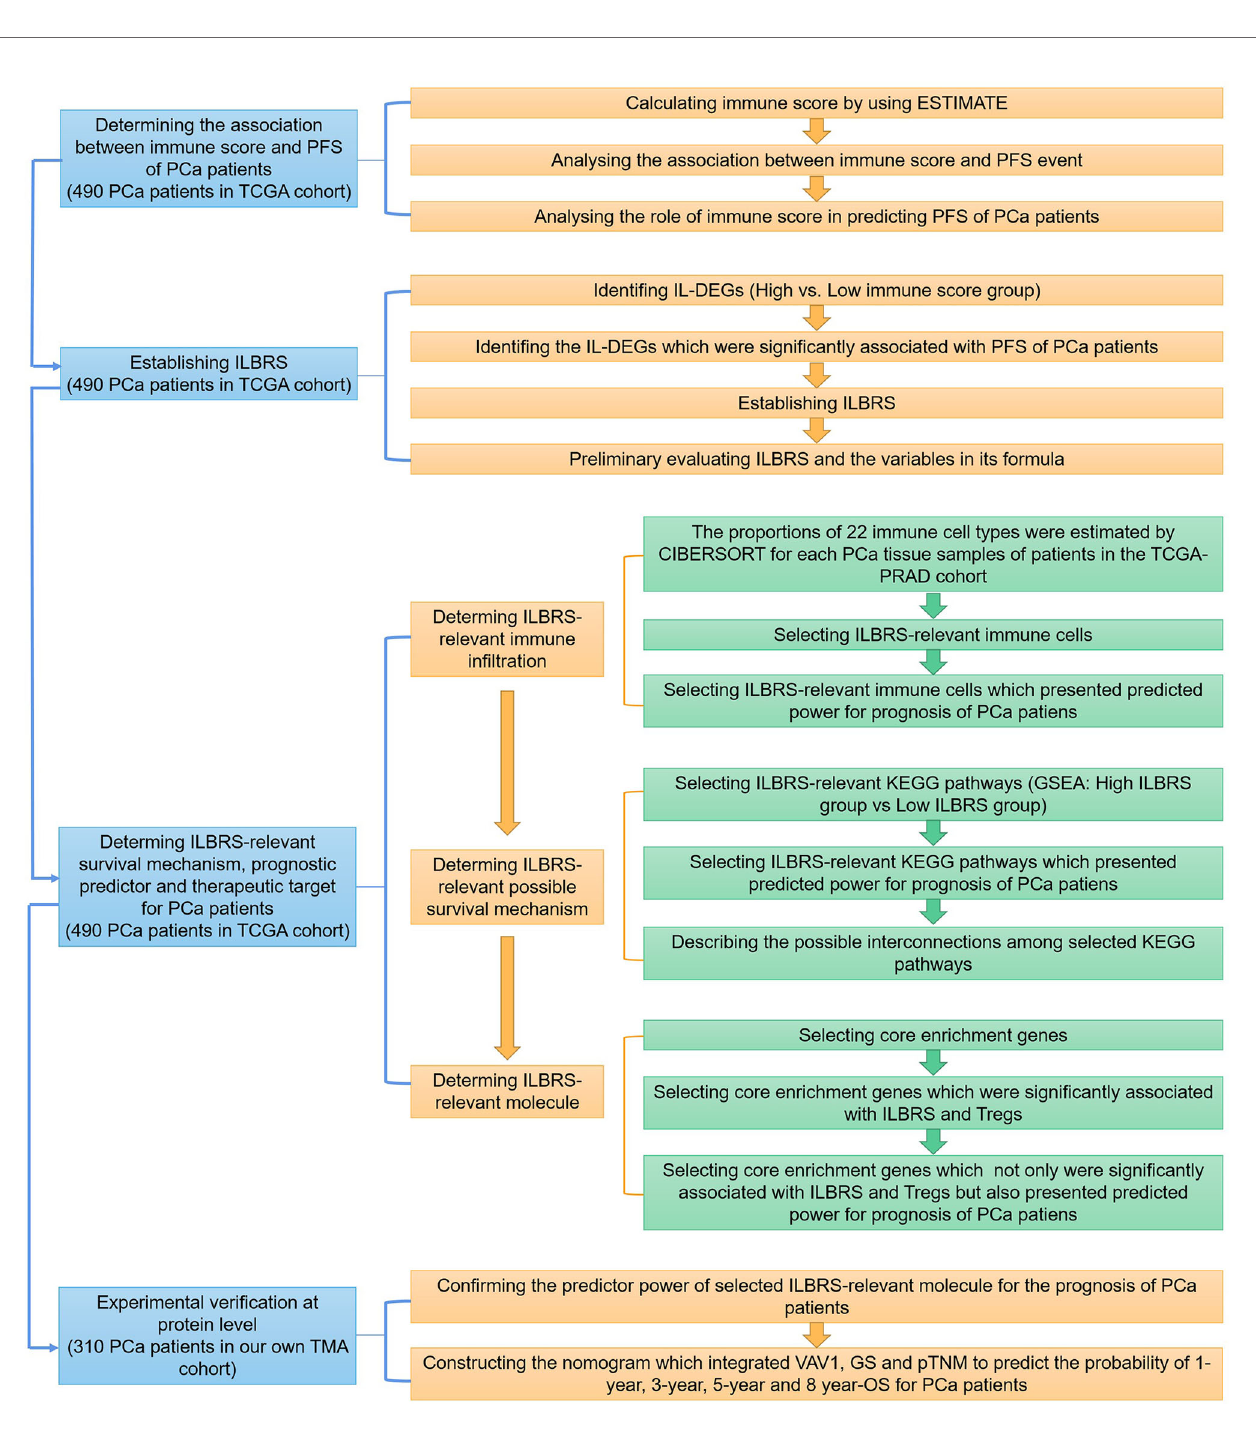
FIGURE 1 | The detailed strategy of discovering the immune landscape-based prognostic predictor and therapeutic target for prostate cancer. ( Figure 2B ). After fi ltering low-abundance genes, the average expression level was lower than 0.01, and 415 IL-DEGs were selected for subsequent PFS analyses. The results of PFS analysis via univariate Cox regression showed that 137 IL-DEGs played a signi fi cant role in predicting PFS in PCa patients ( Table S3 ).